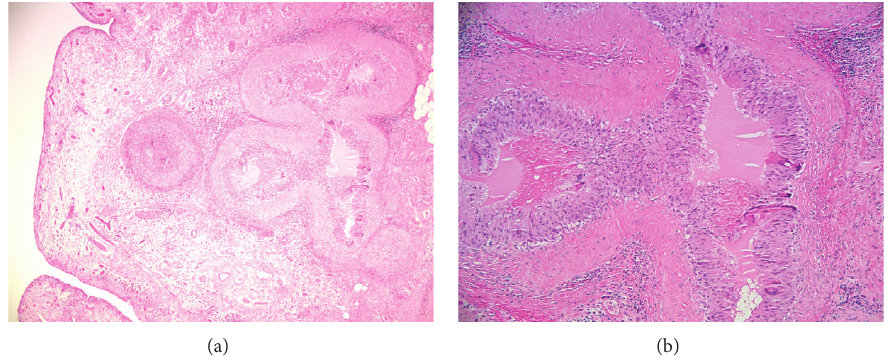
Figure 2: (a) Low power H&E stain of synovial specimen demonstrating granulomatous inflammation. (b) High power image of (a) H&E stain. Central amorphous material